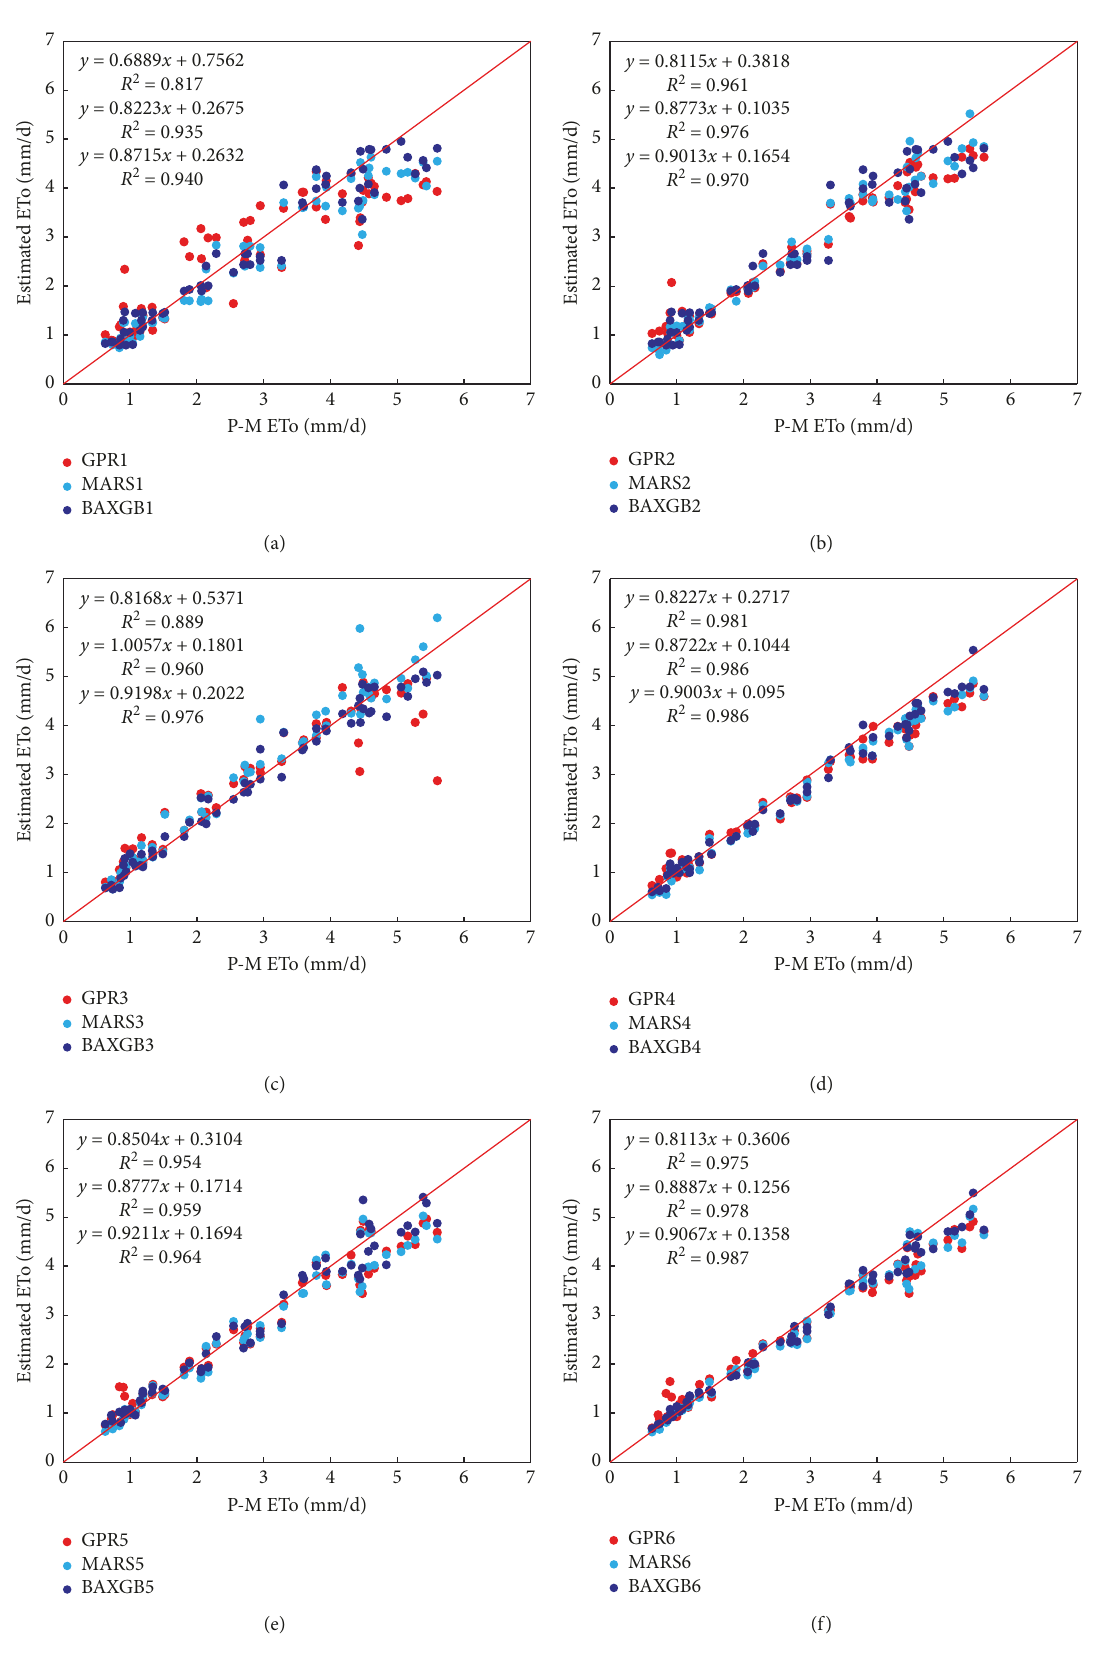
Figure 4: Scatter plots between the estimated ETo by the three algorithms and the FAO-56 P-M ETo in the testing stage for the Datong